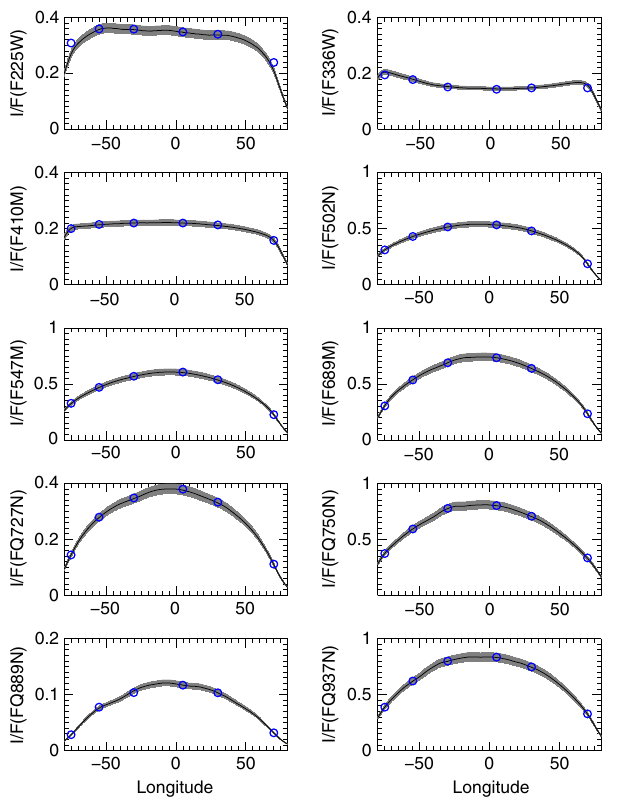
Figure 6 | Radiative transfer models compared with the observed reflectivity. Best-fitting model (blue dots) of the Equatorial Zone center to limb variation of the absolute reflectivity I / F for all HST filters listed in Table 1. The solid lines (with shadowed uncertainties) represent the observed reflectivity and were obtained after smoothing every 1 (cid:2) in longitude to remove particular features from the modelling. Error bars show the 5% confidence level resulting from a number of uncertainty sources 33,34